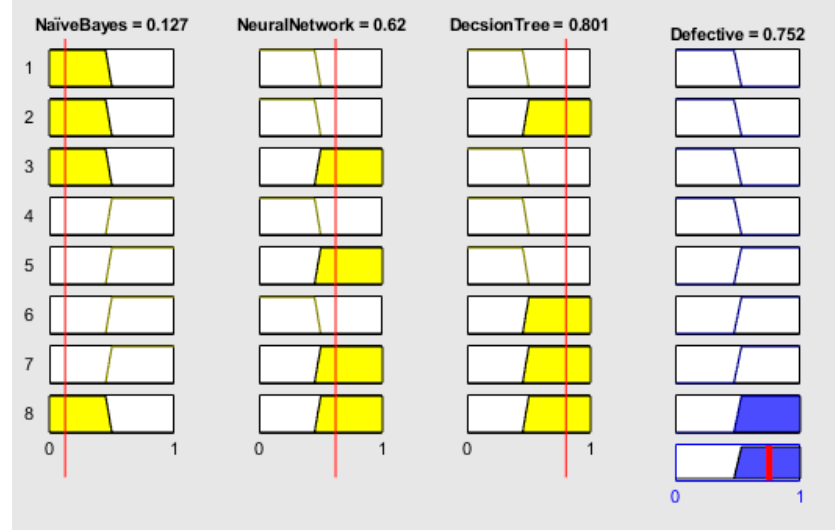
Figure 4. Results of the proposed fuzzy logic-based fusion technique for a defective module (1).